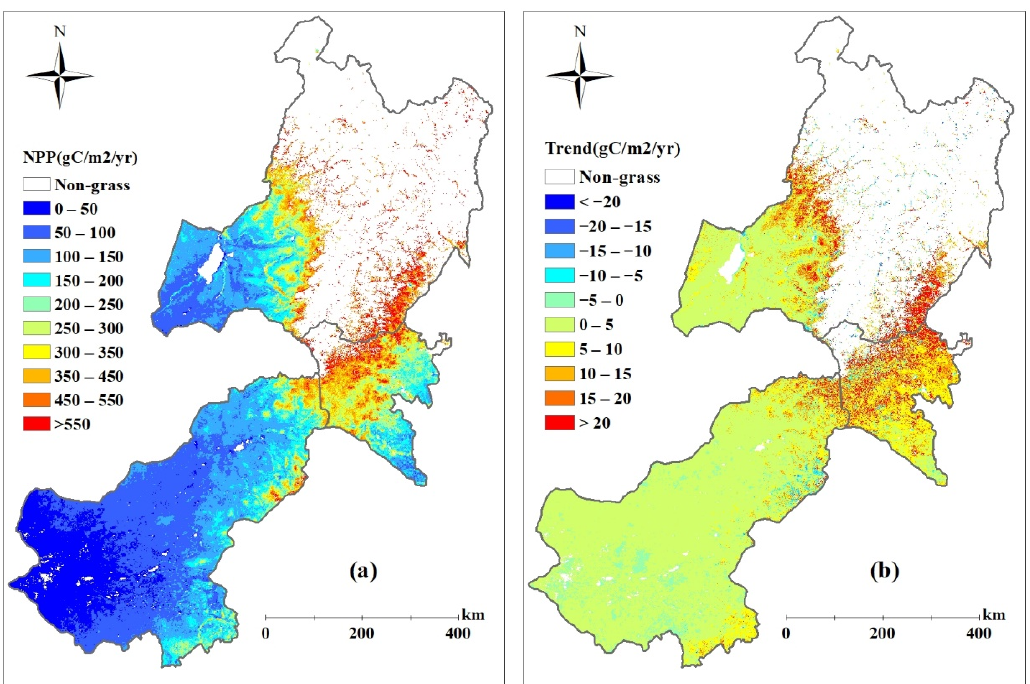
Figure 4. Spatial distribution of simulated averaged ANPP ( a ) and its trends ( b ) over the period of 2000 to 2017 in eastern Inner Mongolia.